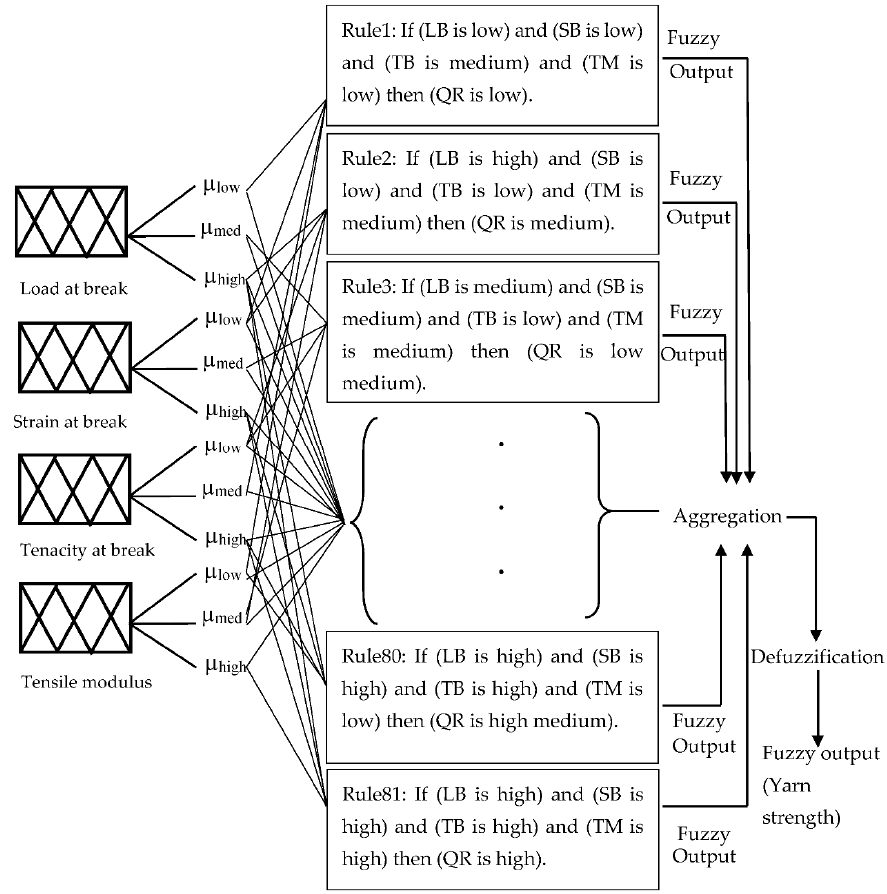
Figure 5. Construction of FIS Model.